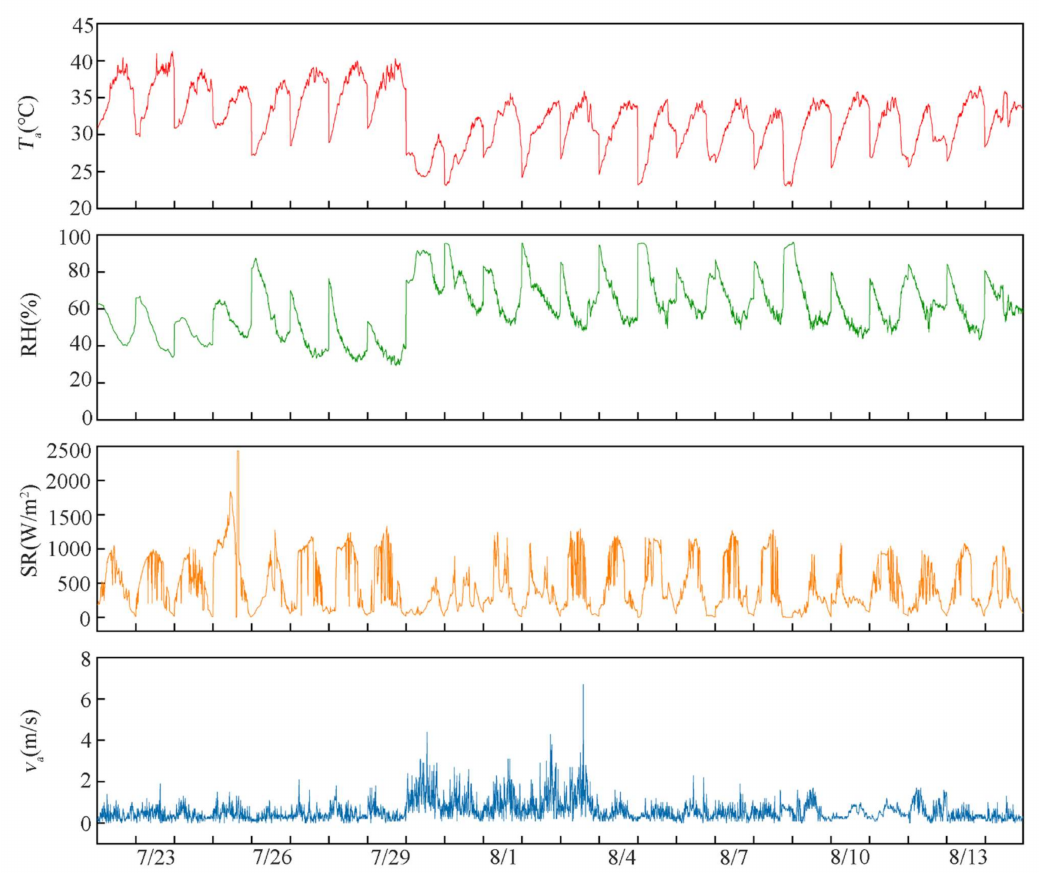
Figure 3. Daytime meteorological parameters measured with an automatic weather